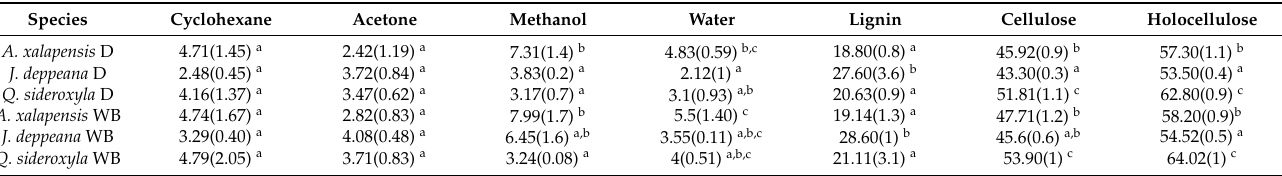
Table 3. Contents (%) of extracts and chemical components of three forest species from the State of Durango, Mexico. Species Cyclohexane Acetone